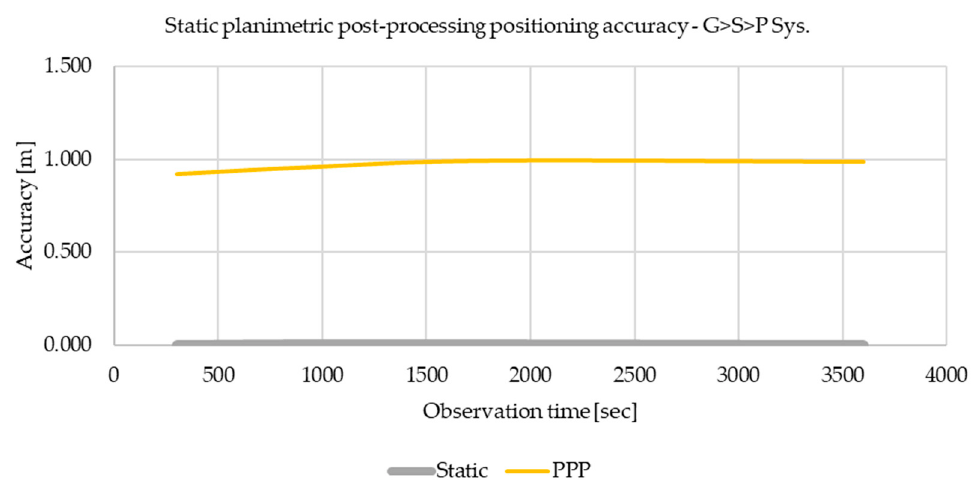
Figure 13. Accuracy in static planimetric post-processing positioning in static mode (grey) and in PPP mode (yellow) of the G > S > P Sys.